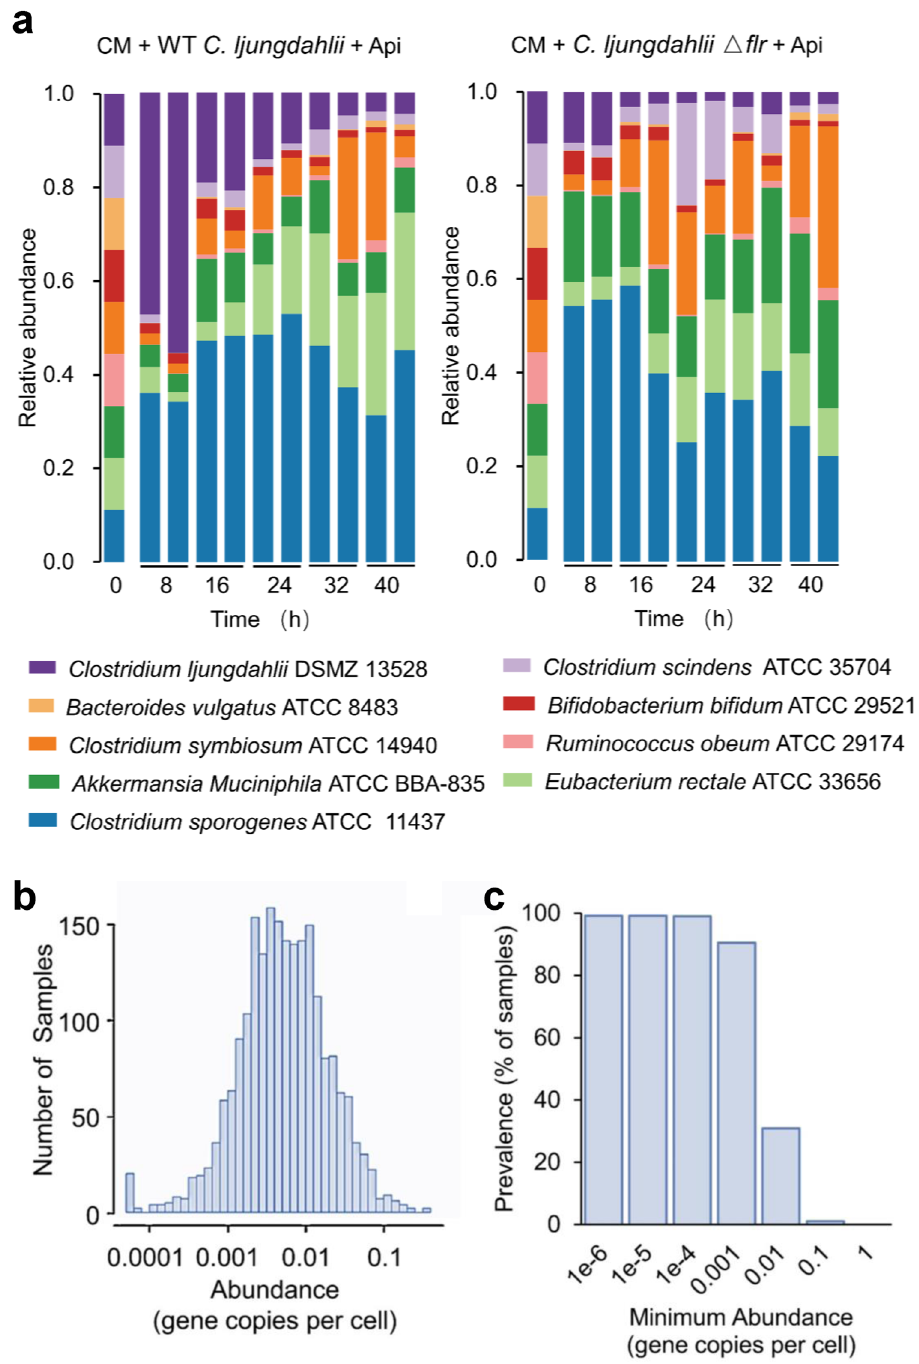
Fig. 6 In fl uence of the fl r gene on gut microbial composition under the pressure of fl avone apigenin and the abundance of fl r -like genes in human gut microbiome. a Comparison of relative abundance of the WT C. ljungdahlii (WT) and C. ljungdahlii Δ f lr ( fl r deletion) strains in a simpli fi ed gut microbiota (containing eight representative human gut bacterial strains without putative fl r genes) under the pressure of apigenin. At the beginning of this experiment, the same volume (2 mL) of the cultures of these strains (OD 600 = 0.8) were mixed; then, 20 mL of the mixture was added aseptically to 200 mL of GMM broth containing 1% mucin and 1 mM apigenin. Therefore, the relative abundance of each strain in this arti fi cial microbial community was considered to be the same at 0 h. The abundance of groEL (marker gene) at different time points relative to that at 0 h was used to indicate the relative abundance of individual strain. CM, simpli fi ed core microbiota consisting of eight representative gut bacterial strains. Api, apigenin. The data of two biologically independent samples were presented at each time point. b , c The abundance of the fl r homologs across human gut microbiome samples ( b ) and the prevalence of the fl r homologs across human gut metagenomes at different abundance thresholds ( c ) based on the human microbiota metagenomic data from